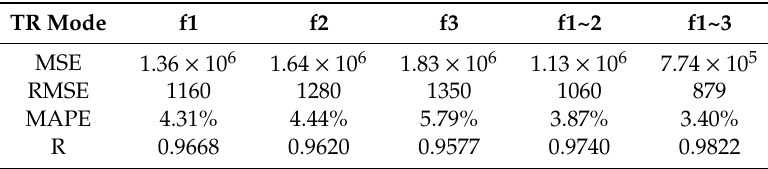
Table 11. Ei predicted by TR mode frequencies with ensemble.